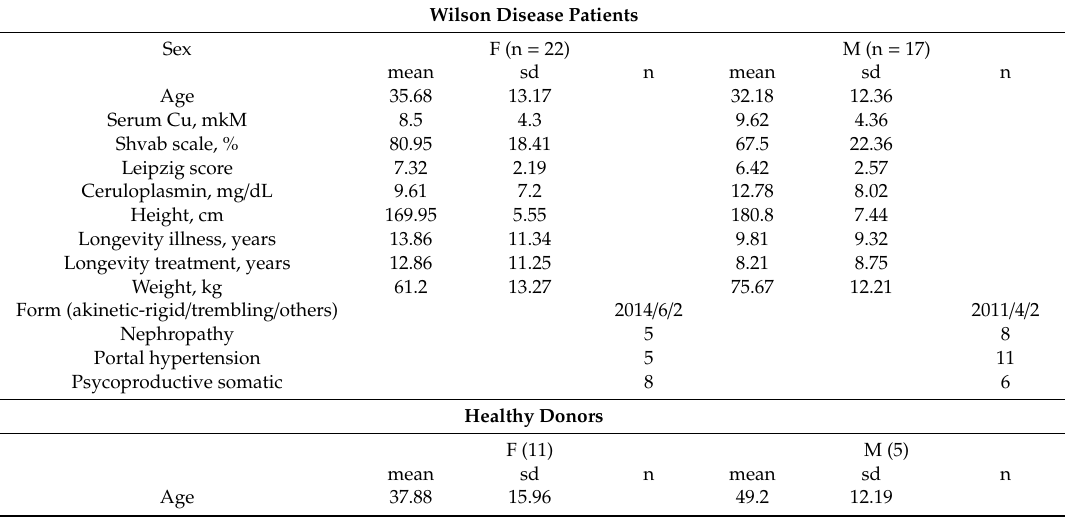
Table 1. Demographic parameters of the patients, disease characteristics, and